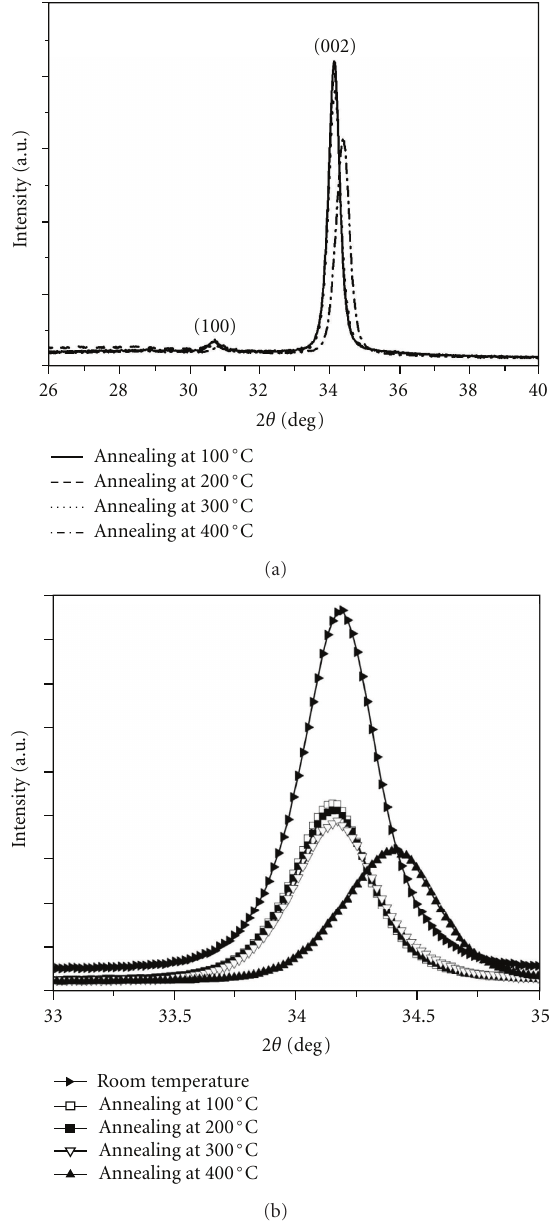
Figure 4: The XRD spectra of AZO films before and after annealing at various temperatures. (a) One small (100) and one big (002) peaks were observed in a range of 26 ◦ to 40 ◦ and (b) detailed variation of (002) peak as a function of annealing